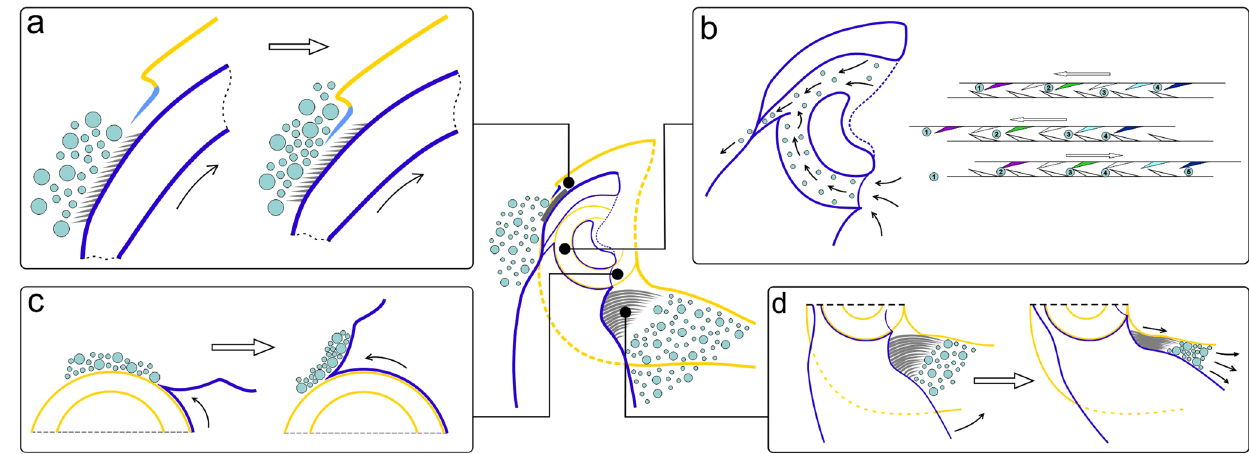
Fig. 6 Schematic representation of the auto-cleaning mechanisms functioning. a Microsetal pad/membraneous plate; b internal cavity; c scraper; d hairy brush.